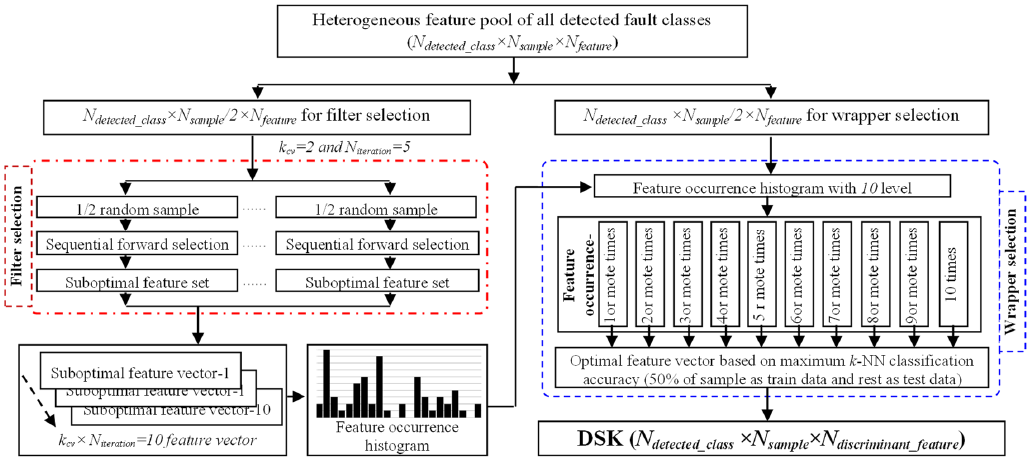
Figure 7. The flow of DSK construction by selecting discriminant fault signatures of detected fault Figure7. TheflowofDSKconstructionbyselectingdiscriminantfaultsignaturesofdetectedfaultmodes. modes.